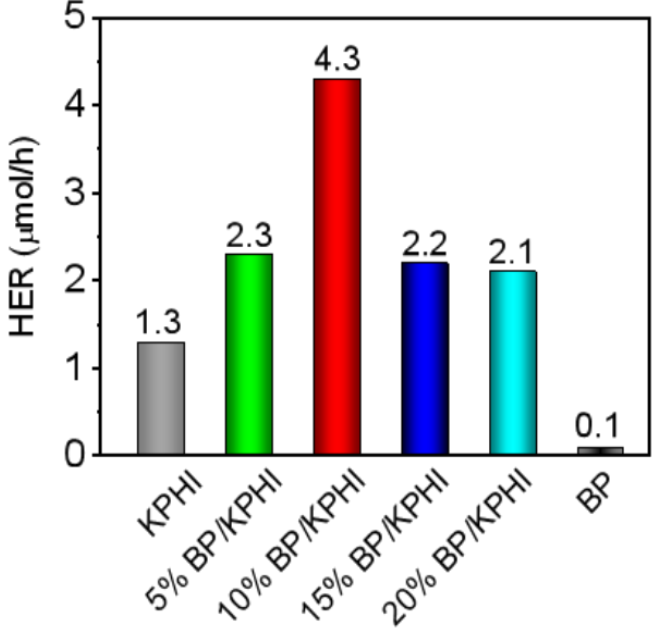
Figure 8. Average hydrogen evolution rate (HER) of 3 wt.% Pt-deposited KPHI and BP/KPHI illuminated by visible light ( λ > 420 nm) for 5 h.